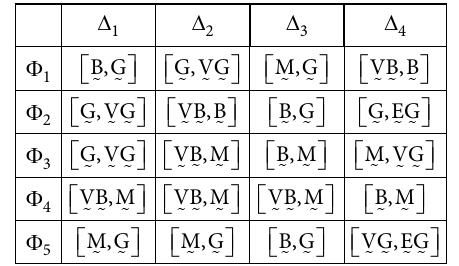
Table 1. The ULT matrix Table 2. The ULT matrix